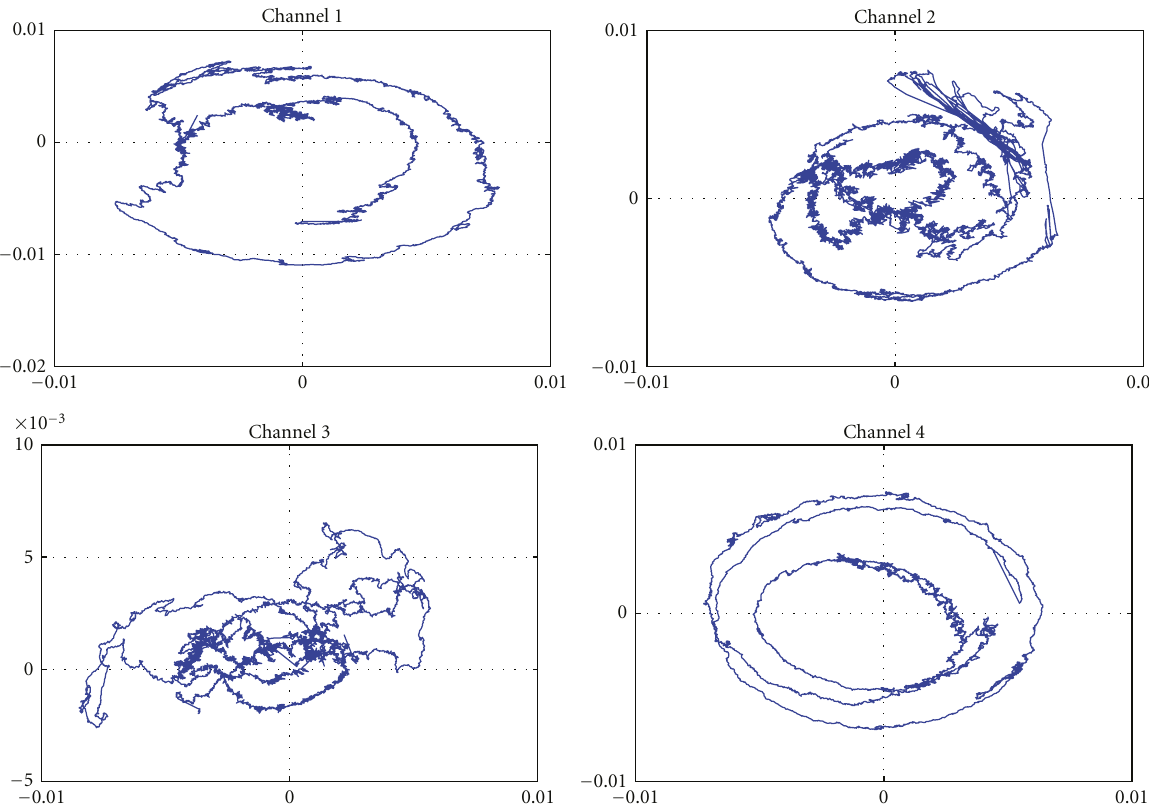
Figure 8: Evolution of the complex channel estimate during one second, for signals received at 45 m distance (path 1, NLoS, 0 . 5 m/s).